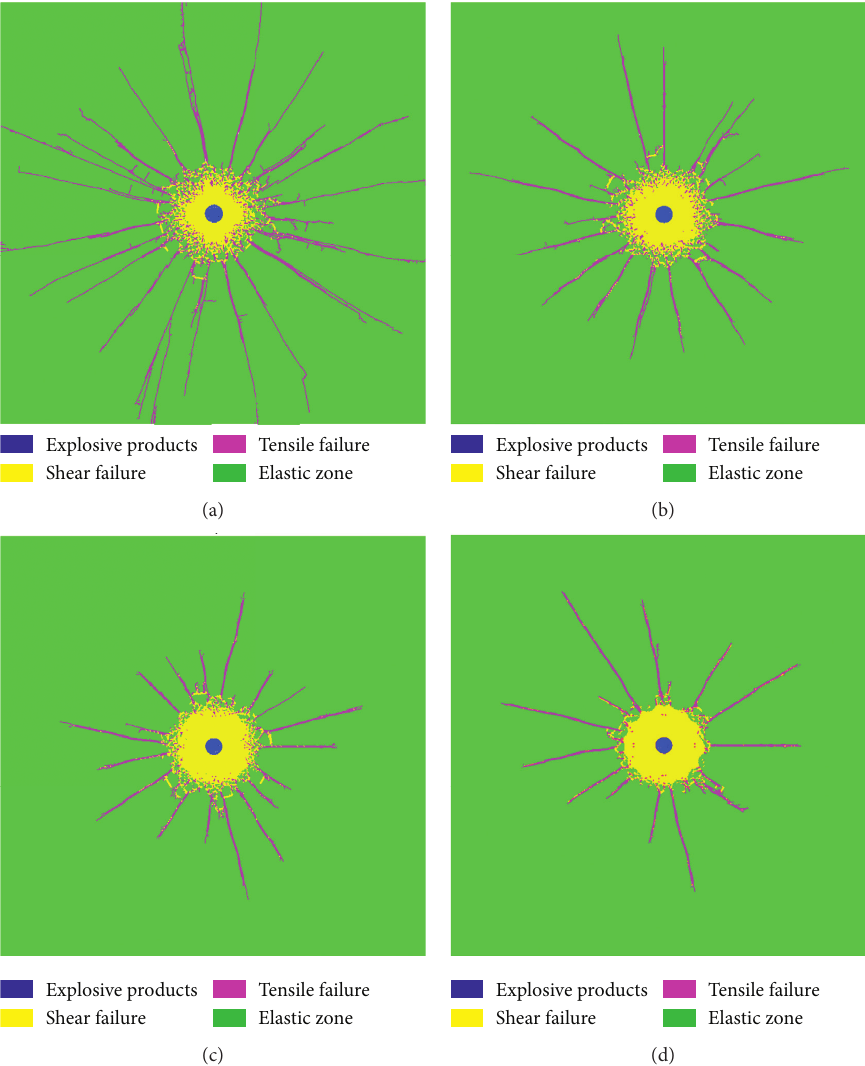
Figure 10: Comparison of blast-induced fractures under different pressures. (a) P (d) P x � P y �